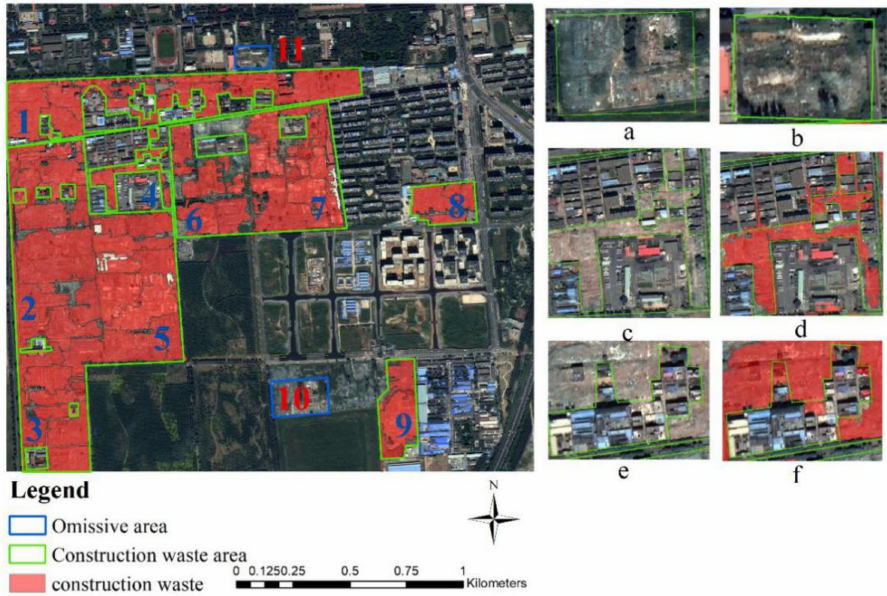
Figure 15. Separability analysis of study area B: ( a , b ) vegetated construction waste, ( c – f ) the con- struction waste